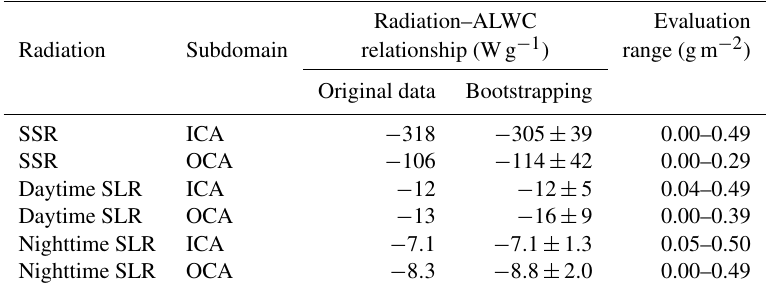
Table 2. Radiation–ALWC relationship (Wg − 1 ) based on linear fits as presented in Fig. 14a–f, including the time period 2 July 15:00UTC to 3 July 15:00UTC. The subdomain denotes whether the captured area is simultaneously cloudy (ICA) or cloud free (OCA) in both realizations. Original data denote the slopes derived from Fig. 14a–f, whereas bootstrapping refers to the median slopes of the 10000 resamples. The confidence intervals are derived by using the Gaussian approximation and α = 0 . 05, and the evaluation range provides the ALWC interval, which is used for the linear